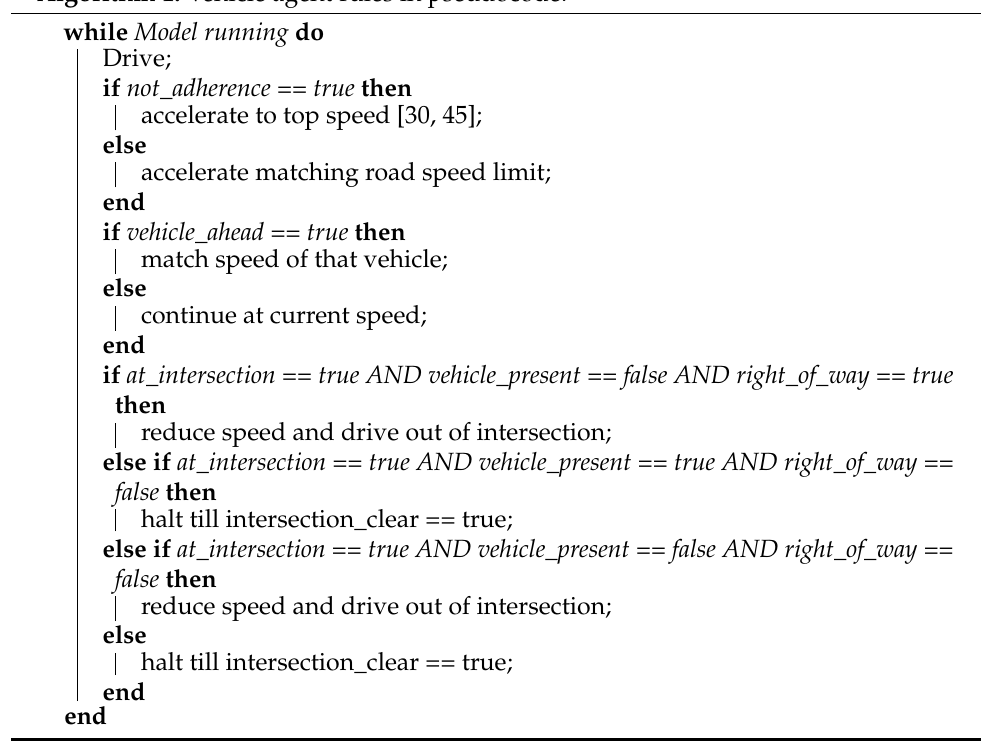
Figure 1. Workflow diagram depicting processes that the Urban Traffic Simulator undergoes during run-time. Algorithm 1: Vehicle agent rules in